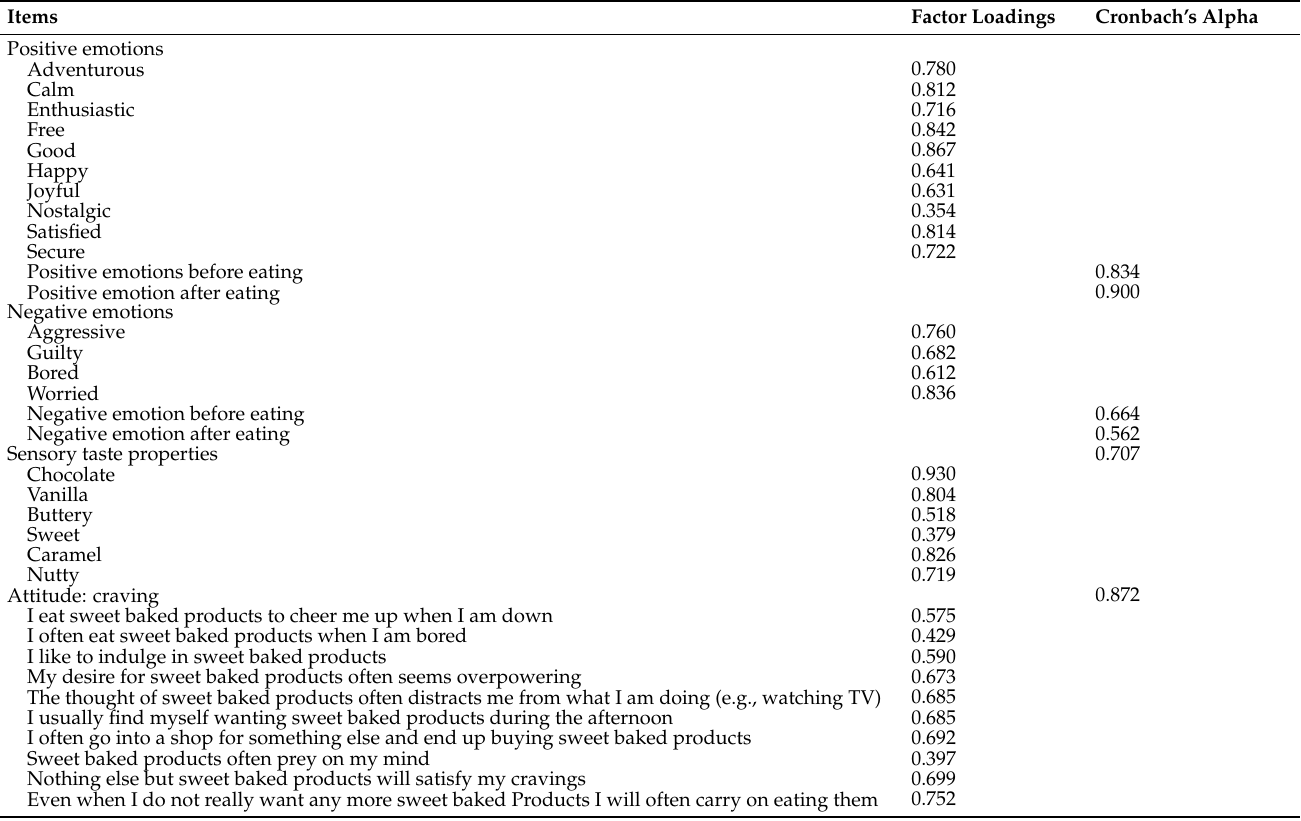
Table A2. Scales and items used for cluster analysis, including internal consistency